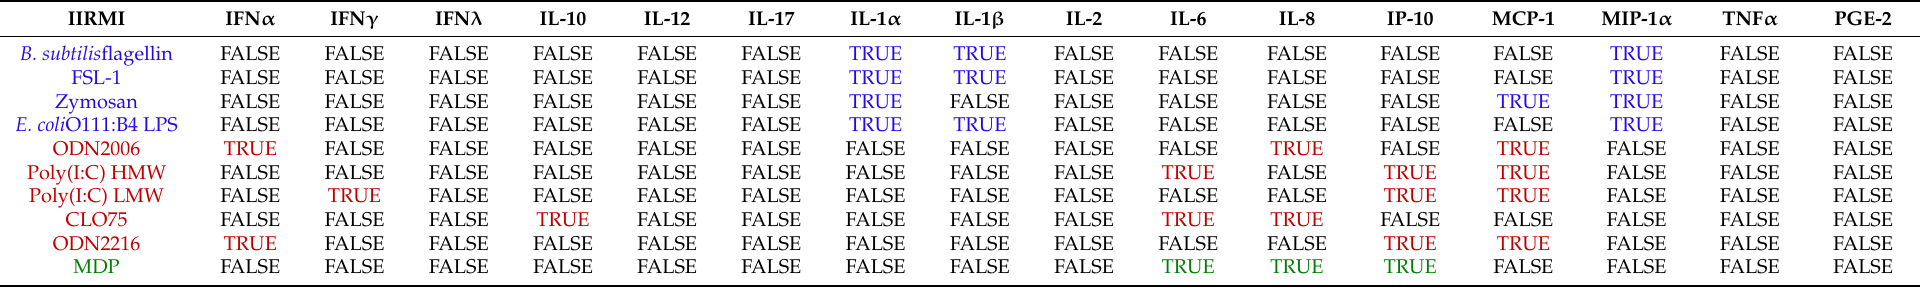
Table 3. Selection of three signature cytokines induced by individual Innate Immune Response Modulating Impurities. A two-sided unpaired Wilcoxon test was used to select the top three cytokines for each IIRMI, which had consistent responses between all donors and the lowest p -value. Starting with the lowest concentration for each IIRMI, if three cytokines did not achieve significance of p ≤ 0.05, the next highest concentration was evaluated until three cytokines were chosen. If more than three cytokines achieved p ≤ 0.05 at the selected concentration, the three with the lowest (most significant) p-values were selected. The top three cytokines selected for any IIRMI are shown as “TRUE” while the remaining less significant cytokines are shown as “FALSE”. IIRMIs are grouped based on the intracellular localization of their cognate pattern-recognition receptors (PRRs) and color-coded as follows: BLUE-cellular membrane, RED-endosome, GREEN-cytosol. TRUE values in each group are highlighted in bold and the same color code as that used for corresponding